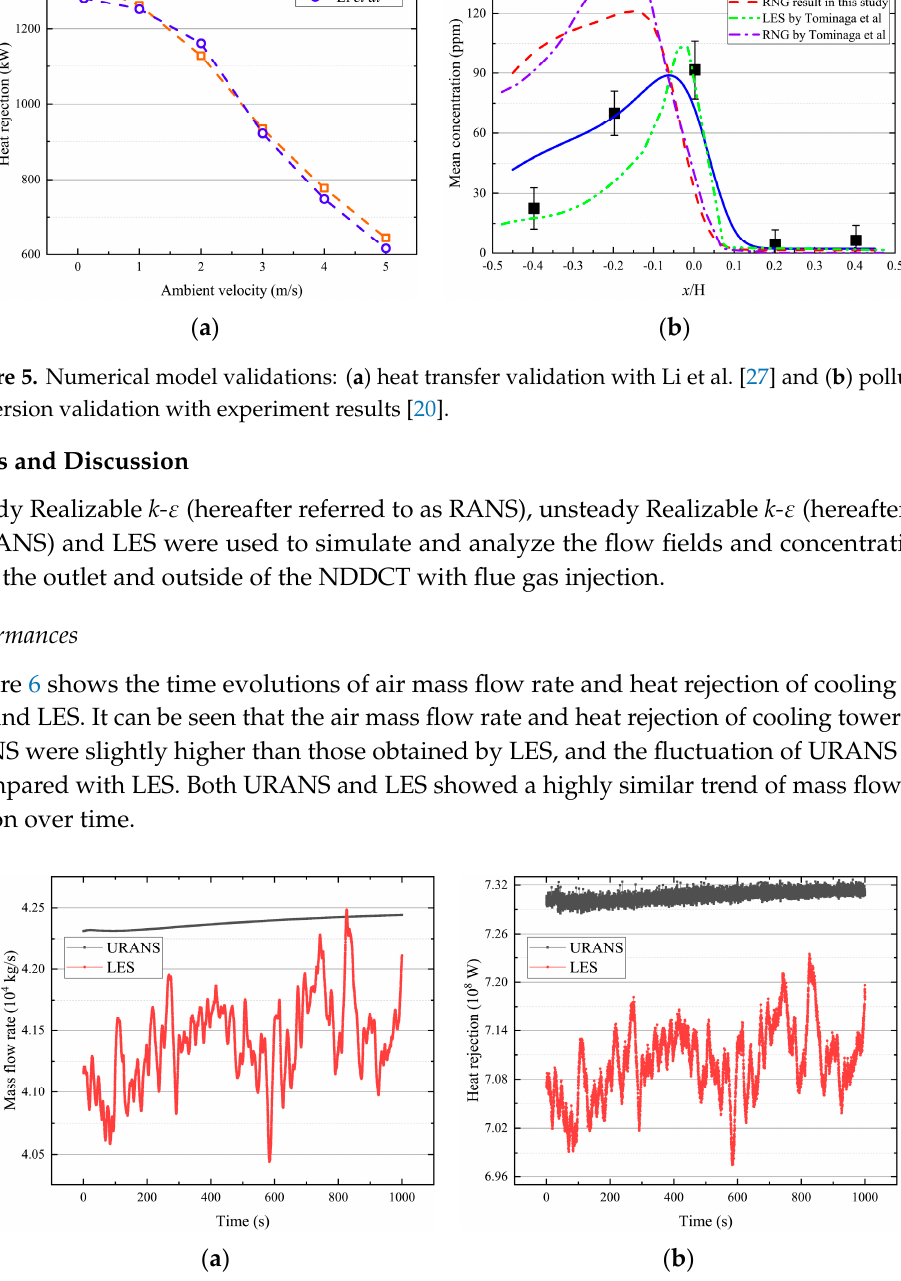
Figure 6. Time history curves of cooling tower performances: ( a ) mass flow rate and ( b ) heat rejection.